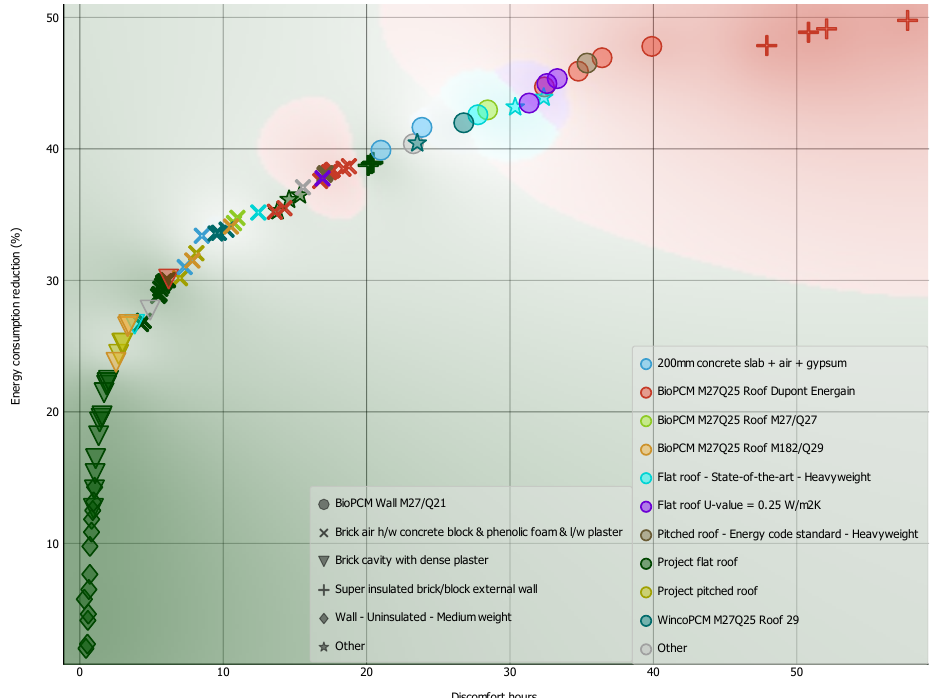
Figure 9. Results of energy consumption reduction (%) for cooling at Pareto’s front for the